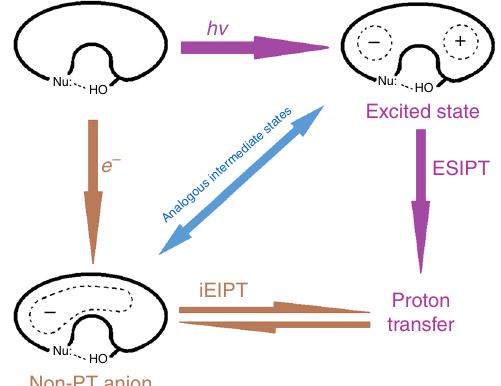
Fig. 5 Proposed mechanism. Mechanisms and correlation of excited-state intramolecular proton transfer (ESIPT) and intramolecular electron-induced proton transfer (iEIPT). Nu nucleophile, Non-PT non-proton-transferred excited state of the neutral, key to the proton transfer, is a charge- transfer state, where the proton receptor part of the molecule is negatively charged and the donor part is positively charged. Hence, the proton ’ s automatic transfer to the negatively charged site of the molecule is driven by the charge separation. In the iEIPT case along the brown arrows, upon electron attachment, the negative charge is delocalized on the ring of the Non-PT isomer; however, it is more localized on the more electronegative Nu: side. In the current case, Nu: is the nitrogen atom, and it